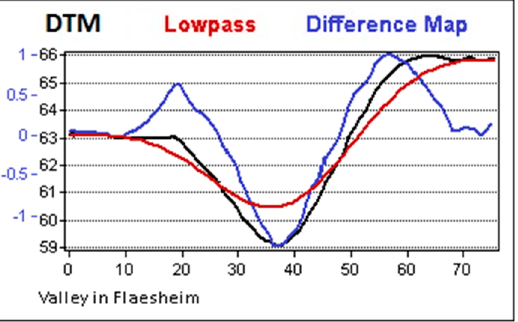
Figure 9. Profile graphs of a valley in a DTM (black), a smoothed DTM (red), and the final Difference Map (blue) [13].